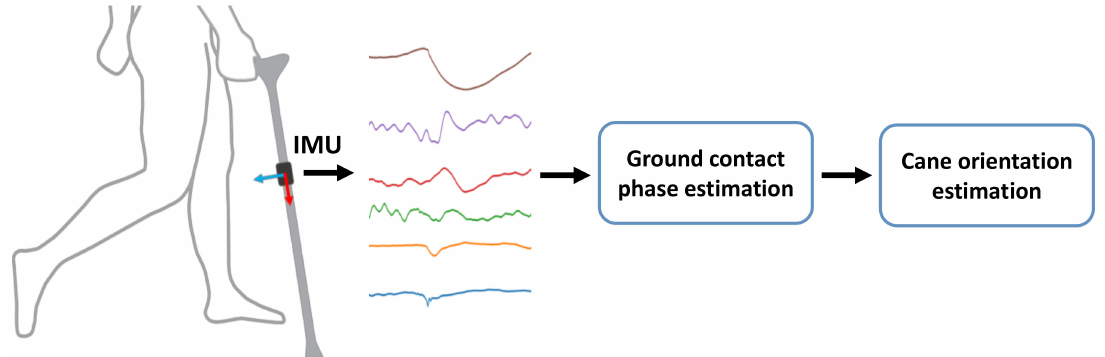
Figure 1. Workflow of the proposed system for estimating the ground-contact phase and 3D cane orientation from inertial sensor data (IMU = inertial measurement